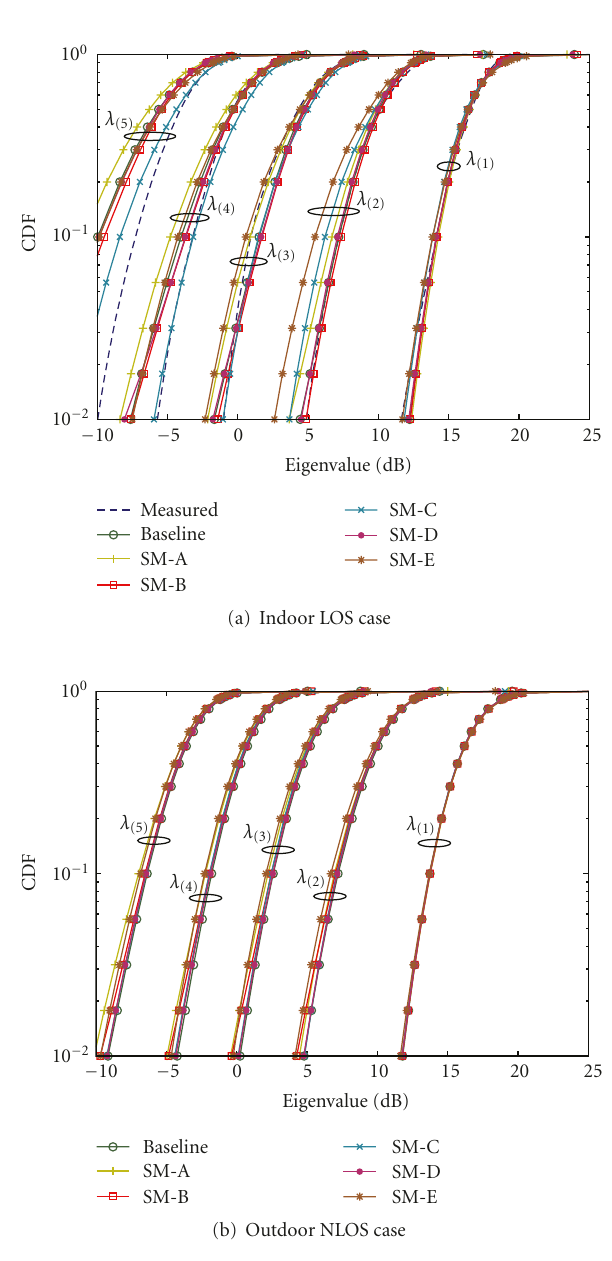
Figure 6: CDFs of the first five principal eigenvalues for baseline and simplified cases.